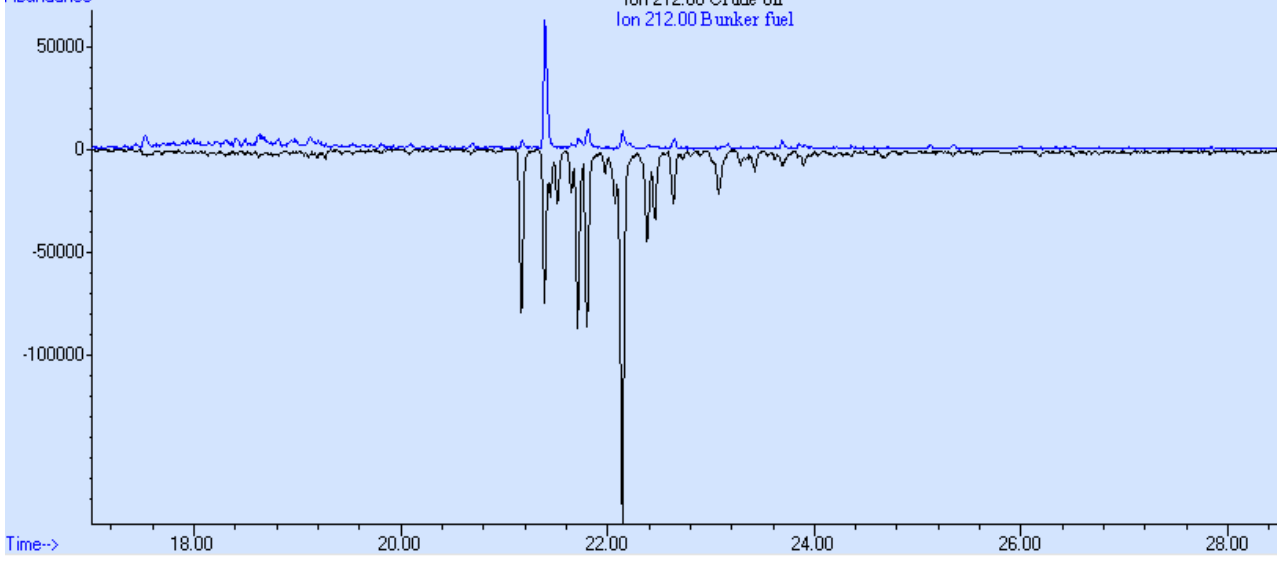
Figure 8. Comparison of EIC at m/z 212 between crude oil and bunker oil samples.